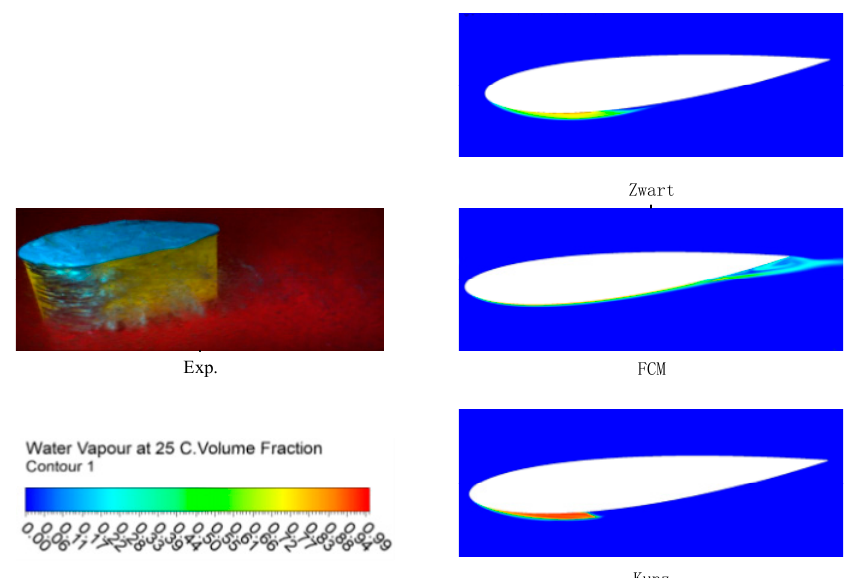
Figure 3. Cavity structures of sheet cavitation around NACA0015 hydrofoil ( σ = 1.075, α = 6 0 °).